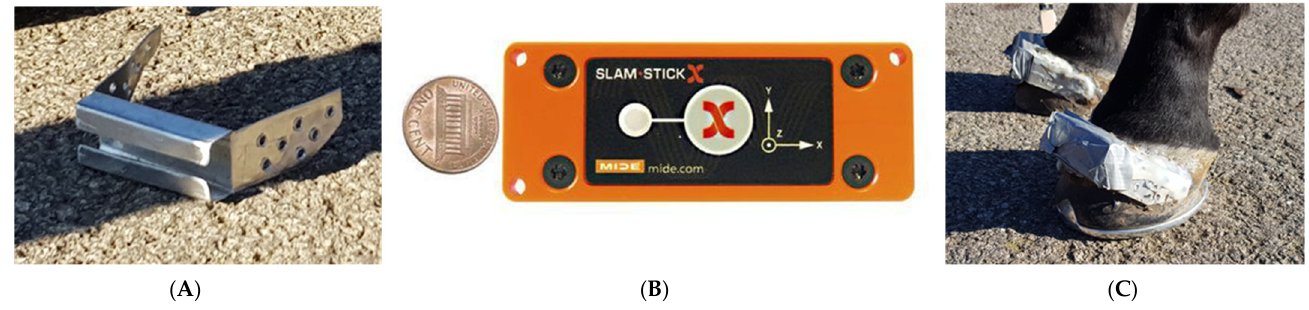
Figure 1. ( A ) Aluminium bracket. ( B ) Slamstick accelerometer. ( C ) Accelerometer and bracket system mounted to hoof.